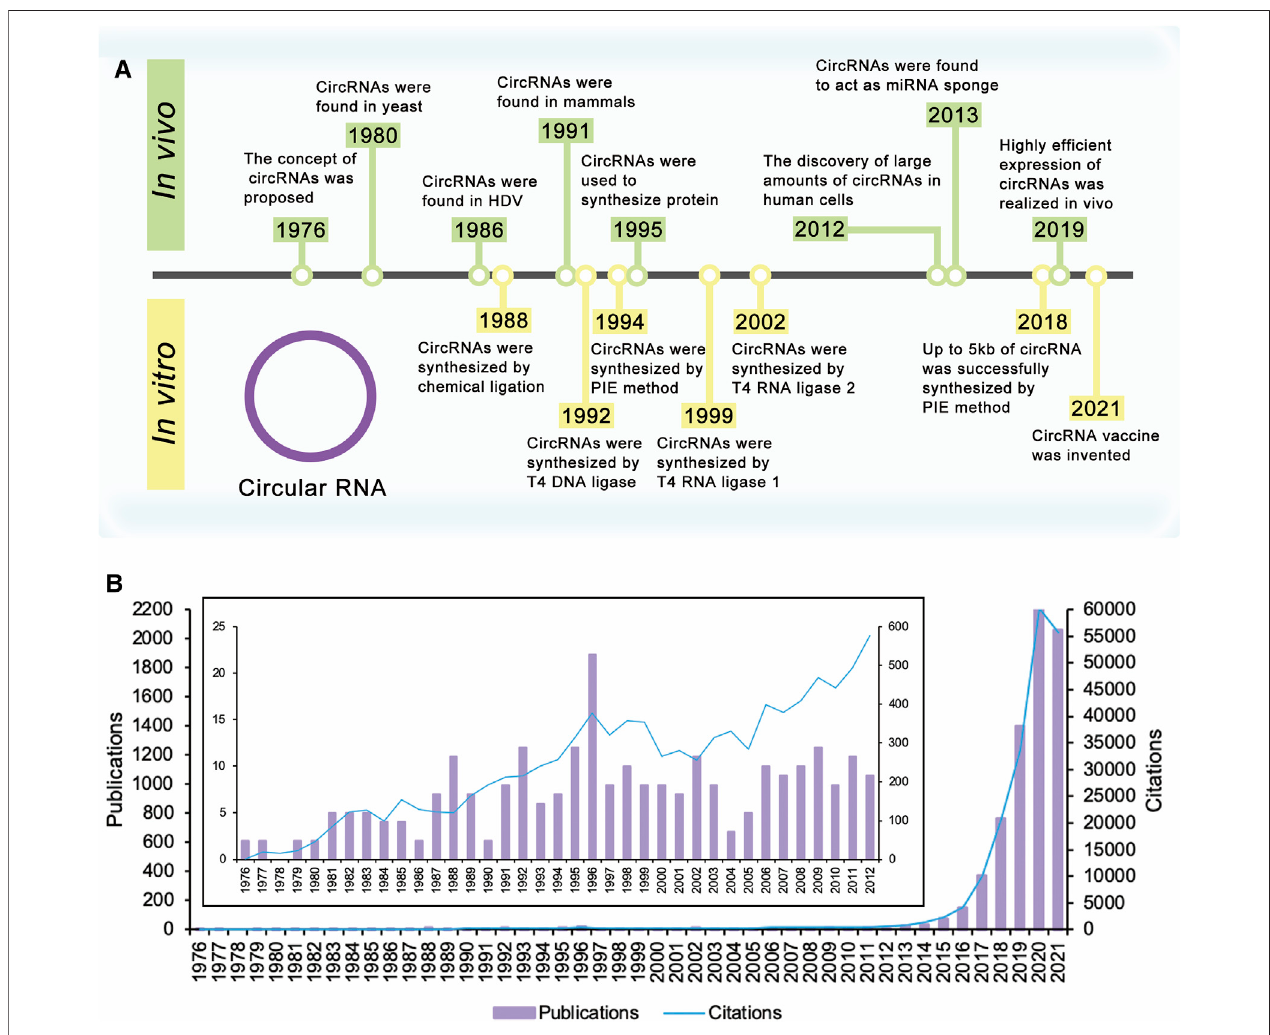
FIGURE 1 | Timeline of circular RNA. (A) The concept of circRNAs was proposed in 1976. Extensive research on circRNAs began in 2012 with the discovery of large amounts of circRNAs in human cells. These researches have improved yields of circRNAs, realized the synthesis of large circRNA molecules, and expanded the applicationsofcircRNAs. (B) Timescitedandpublicationsovertime.TherewereafewpublicationsaboutcircRNAsbefore2012.Sincethediscoveryoflargeamountsof circRNAs in human cells in 2012, the number of publications and citations has increased year by year and is still rising.